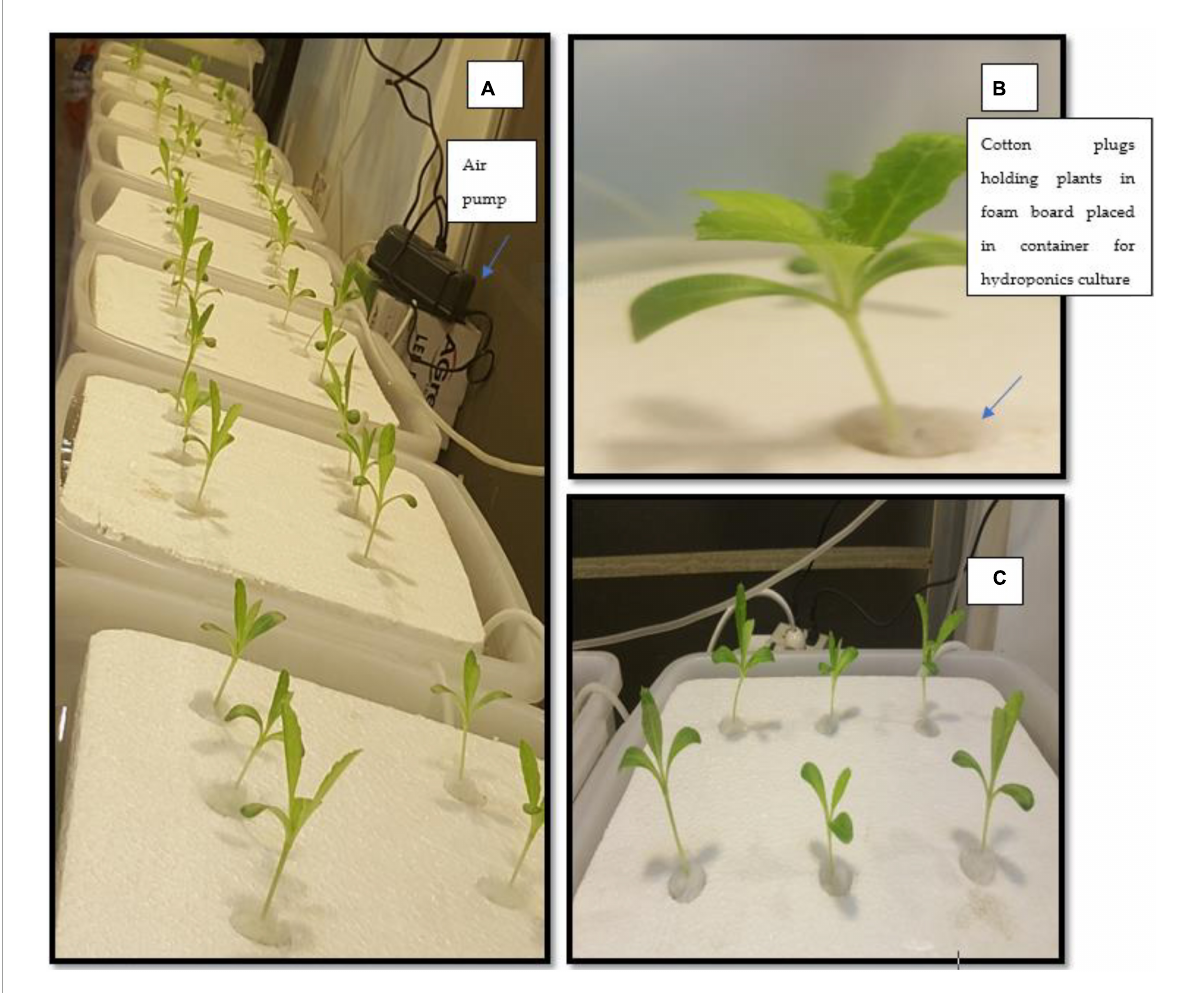
FIGURE1 Hydroponically grown seedlings of Silybum marianum .